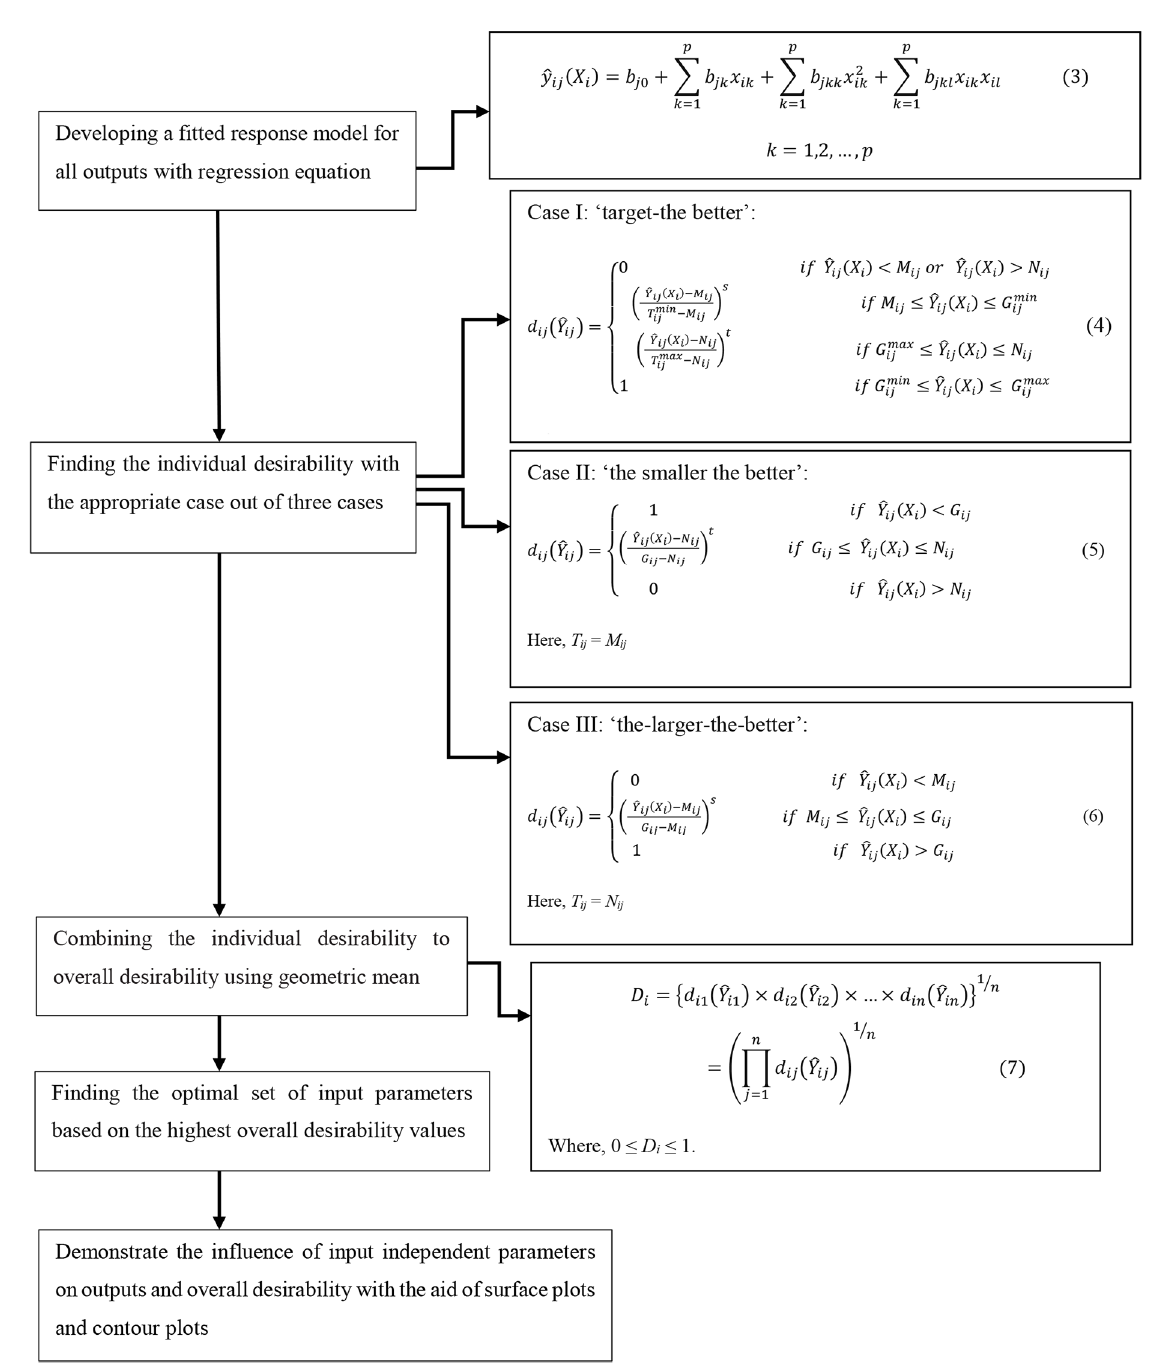
Figure 5. Flowchart of DFA methodology.